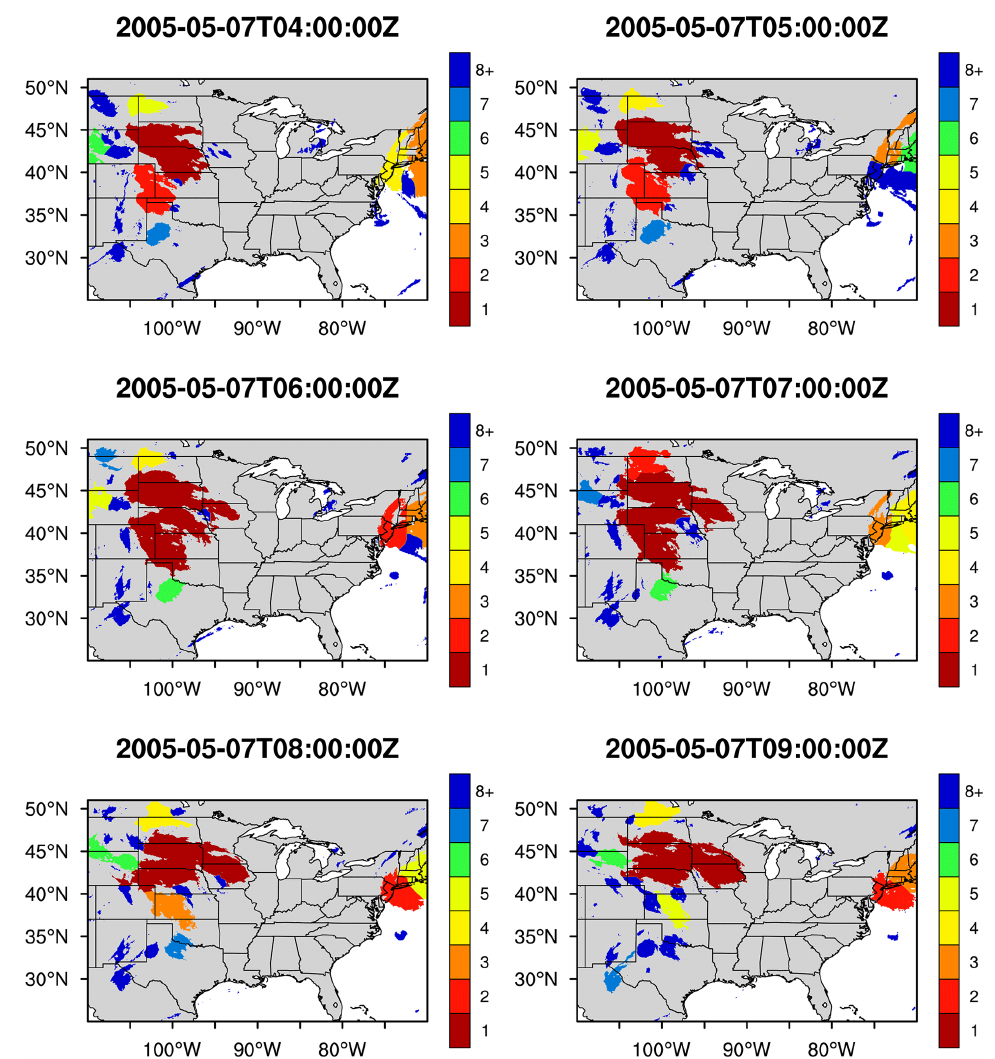
Figure A2. An example of CCS merging and splitting from 2005-05-07T04:00:00Z–T09:00:00Z. Cloud 1 and Cloud 2 at 05:00:00Z merged into Cloud 1 at 06:00:00Z. And Cloud 1 at 7:00:00Z at least split to Cloud 1 and Cloud 3 at 08:00:00Z.